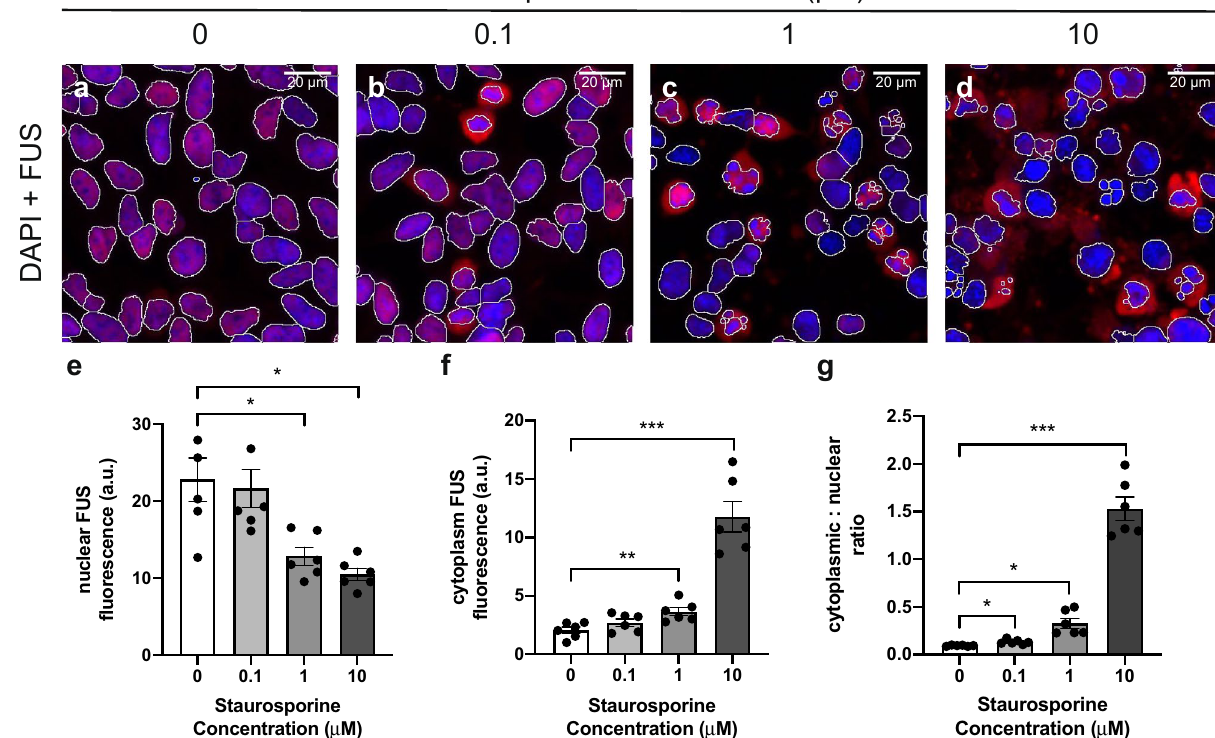
Figure 2. Detection of endogenous FUS cytoplasmic mislocalisation following staurosporine treatment. ( a – d ) Representative fluorescence images of SH-SY5Y cells treated with increasing concentrations of staurosporine. FUS was detected by immunofluorescent staining (red) and nuclei were visualised with DAPI (blue). ( e ) Quantification of nuclear and ( f ) cytoplasmic FUS fluorescence intensity show significant changes in 1 μM- and 10 μM-treated cells. ( g ) Quantification of the FUS cytoplasmic/nuclear ratio shows an increase in all treatment groups when compared to those treated with DMSO alone. Scale bars = 20 μm. Data is represented as mean ± SEM. a.u. arbitrary units. *p < 0.05; **p < 0.01; ***p <